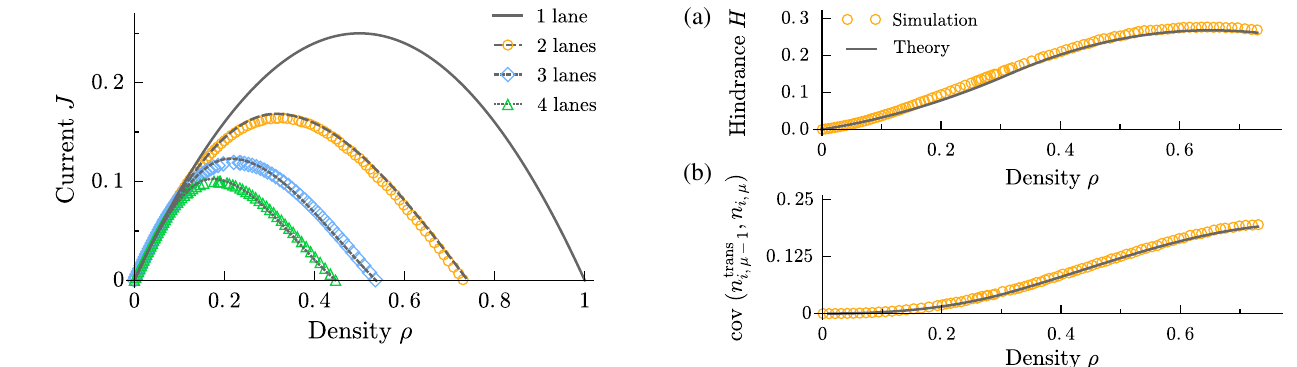
FIG. 6. Comparison of the developed theory for the strength of topological hindrance with simulations for W ¼ 2 , L ¼ 4096 , and δ ¼ 1 = 2 . (a) Hindrance function H in the bulk as a function of the density ρ . Results from simulations (symbols) verify the continuous approximation of the hindrance function (lines). (b) The construction of H can be used for an accurate prediction of correlations of occupations between neighboring sites in the bulk. The prediction for the covariance cov ð n trans i; μ − 1 ; n i; μ Þ in the bulk agrees well with simulation results. (see Here, n trans i; μ ≔ n T i; μ þ n S i − 1 ; μ is the total occupation of S and T max particles of two neighboring lattice sites in the transversal direction. For the theory, ρ was taken from our analytic max approach (see Appendix